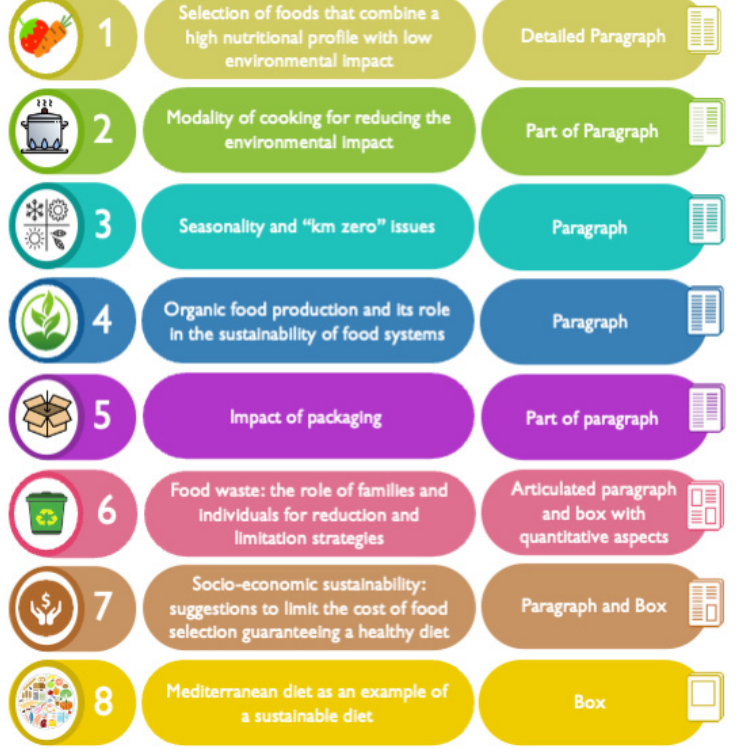
Figure 1. Content of the IDGs’ sustainability chapter (directive 13) and how the subjects were pre-